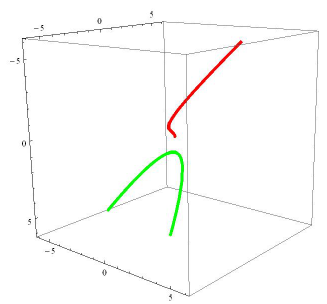
Figure 3. The positions of r (red) and ¯ r (green).